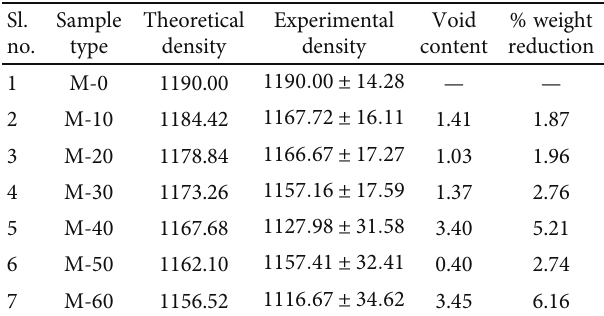
Table 2: Theoretical and experimental densities of prepared